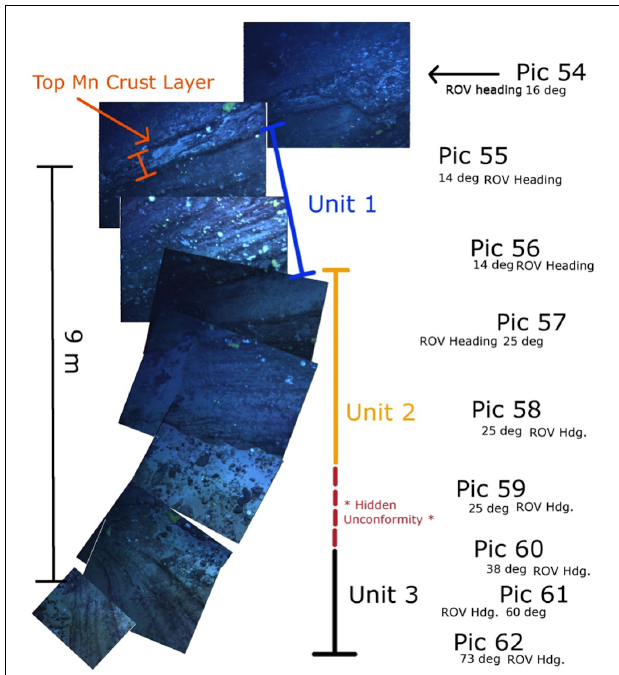
FIGURE 10 | Video frame grabs as ROPOS traveled down the exposed SW side of the NE OK mound in dive R1343. The picture ID is labeled ‘Pic’ and the heading of ROPOS is shown below the picture ID. Units 1 and 2 are of the same strike and dip; however Unit 2 has thicker bedded layers than Unit 1. Unit 3 is of a different strike than Units 1 and 2, and has no apparent dip. The summary of all strike and dip observations on the mound are presented in Figure 7C .